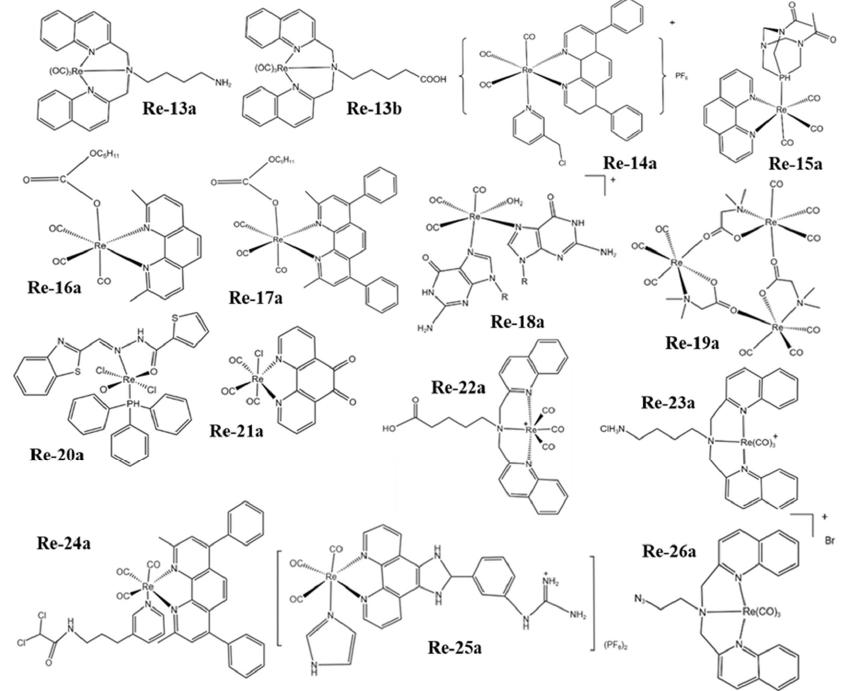
Molecules 2023 , 28 , x FOR PEER REVIEW Figure 2. The structures of some Re complexes (Re-13a − Re-26a) involved in this review.